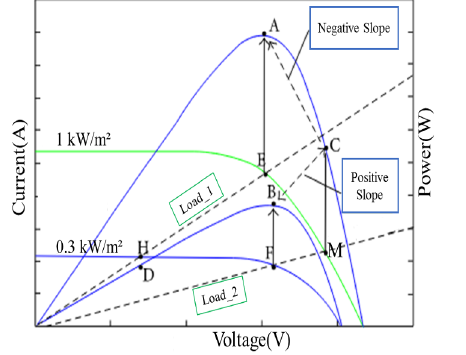
Figure 12: The second part of theAlgorithm associated with the